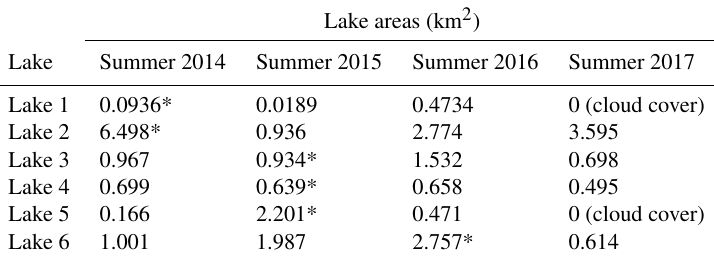
Table 2. Maximum lake area for each summer generated by calculating the maximum NDWI ice per pixel from May to August each year. The lake NDWI ice threshold is set at 0.25, and area is calculated based on all pixels in the lake above this